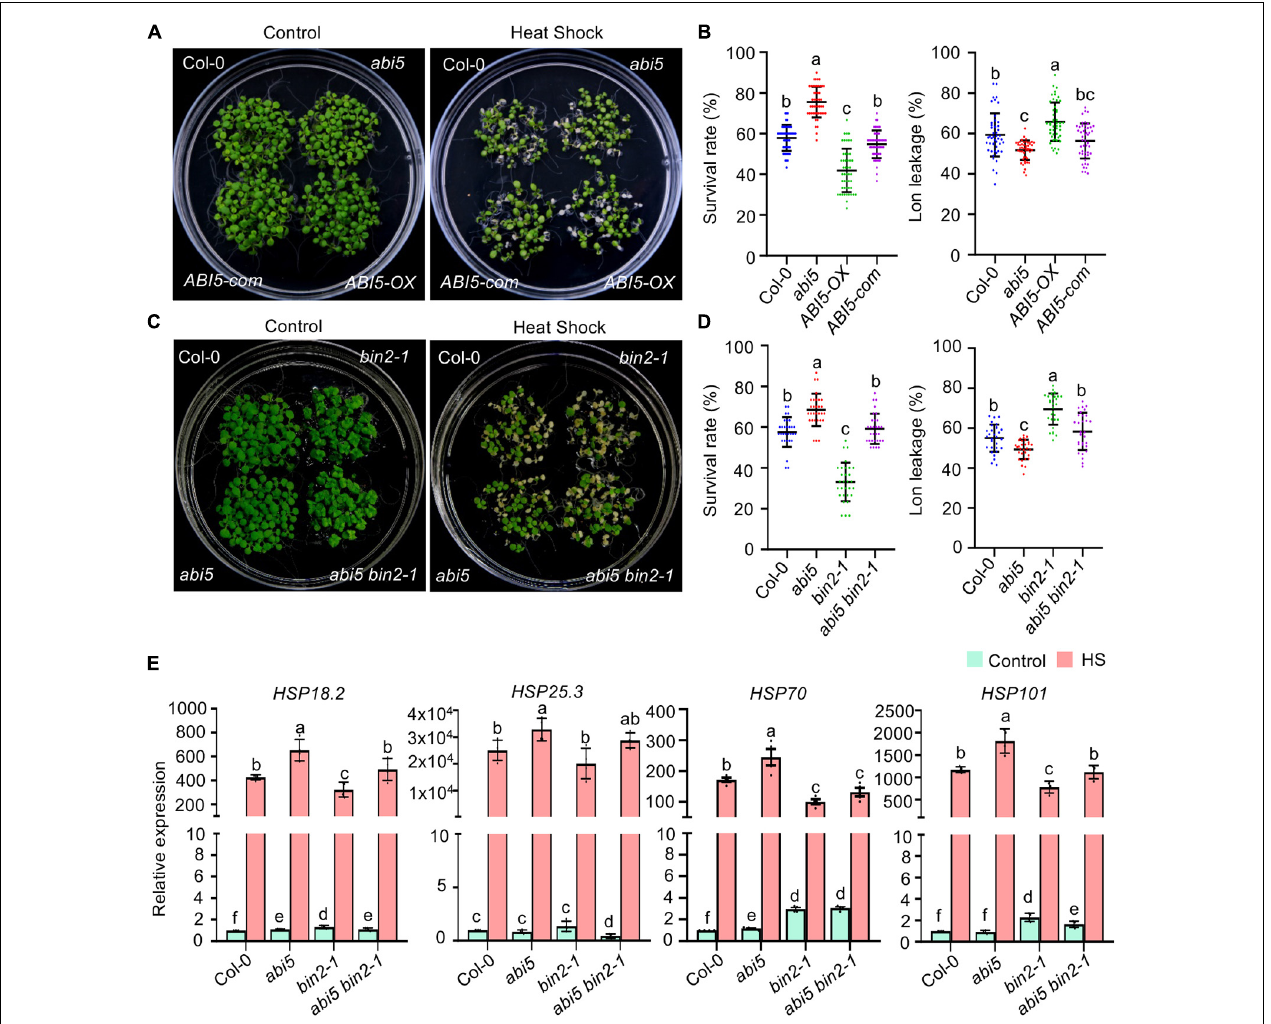
FIGURE 6 | Abscisic acid (ABA) INSENSITIVE 5 (ABI5) functions downstream of BIN2 to regulate acquired thermotolerance in Arabidopsis . (A,C) Photographs of HS-treated and untreated plants after 3 days of recovery at 22 ◦ C. ABI5-com is an ABI5 complementation line in the abi5 background. ABI5-OX was produced in the Col-0 background. (B,D) Quantification of the survival rates of and ion leakage from the plants shown in panels (A,C) . Error bars indicate the mean ± SD. Statistically significant differences are indicated by different lowercase letters ( p < 0.05, one-way ANOVA). (E) Quantitation of HSPs transcript levels in one-week-old plants that were treated with 22 ◦ C (control) or 37 ◦ C (HS) for 1 h. Error bars indicate the mean ± SD ( n = 4). Statistically significant differences are indicated by different lowercase letters ( p < 0.05, Student’s t